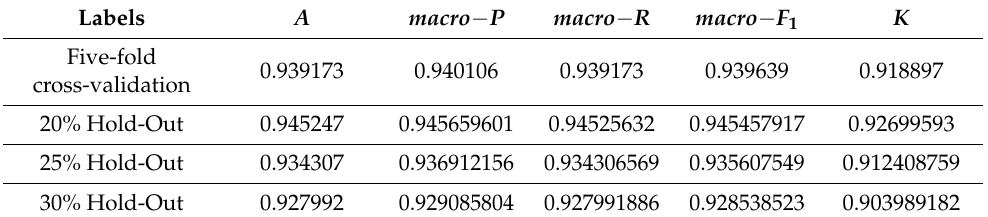
Table 8. Statistical table of numerical indicators of different validation methods.